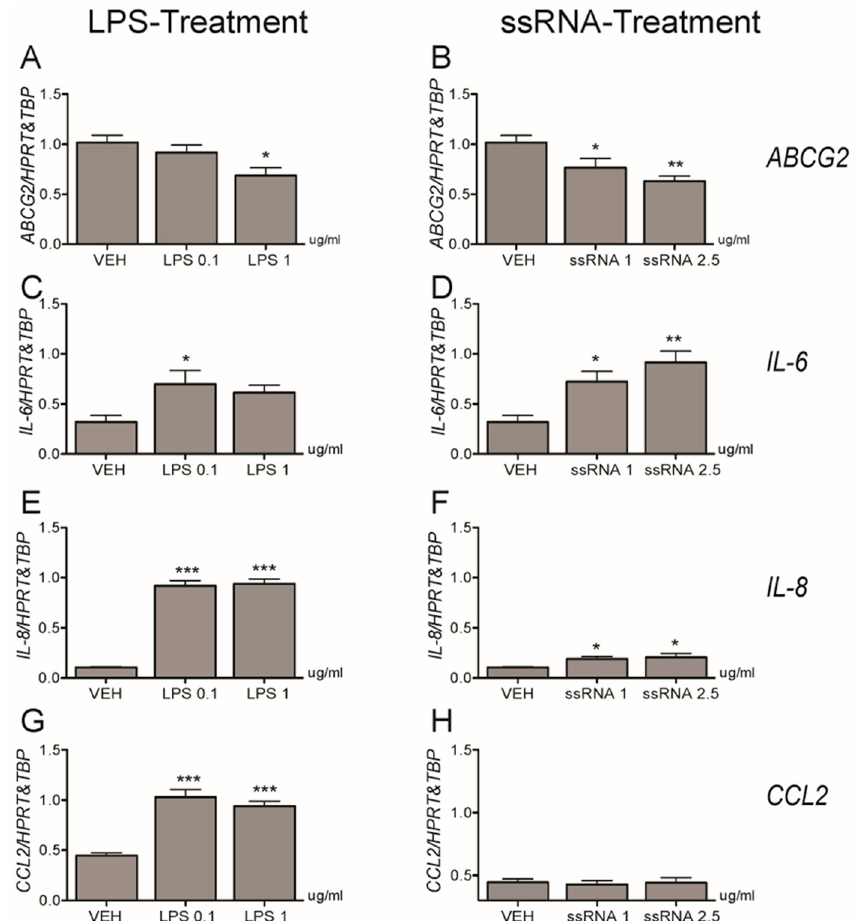
Figure 4. Effects of lipopolysaccharide (LPS, left panel) and single stranded RNA (ssRNA, right panel) on ABCG2 ( A , B ), IL-6 ( C , D ), IL-8 ( E , F ), and CCL2 ( G , H ) expression in human HTR8/SVneo cells. Cells were treated with LPS (0.1 or 1 µg/mL) or ssRNA (1 or 2.5 µg/mL) or their vehicle control (VEH) for 12 h. mRNA expression was assessed by qPCR and the geometric mean of the two reference genes: HPRT and TBP were used for normalization. Data are expressed as means ± SEM, n = 6 per group. Statistical differences were tested by one-way ANOVA followed by the Newman-Keuls post-hoc test. * p < 0.05, ** p < 0.01, and *** p < 0.001 versus VEH.